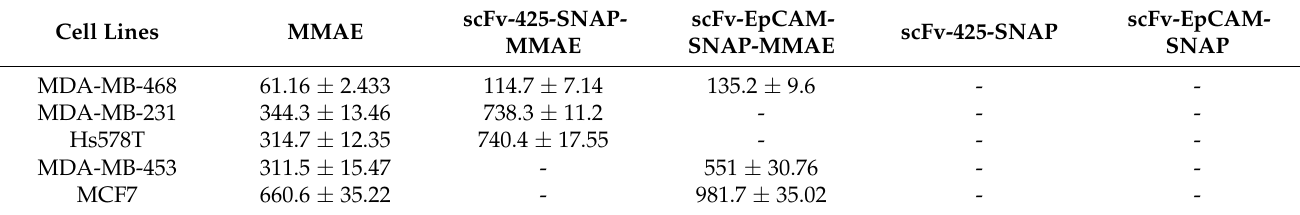
Table 1. IC 50 values (nM) of MMAE, scFv-SNAP fusion proteins and corresponding